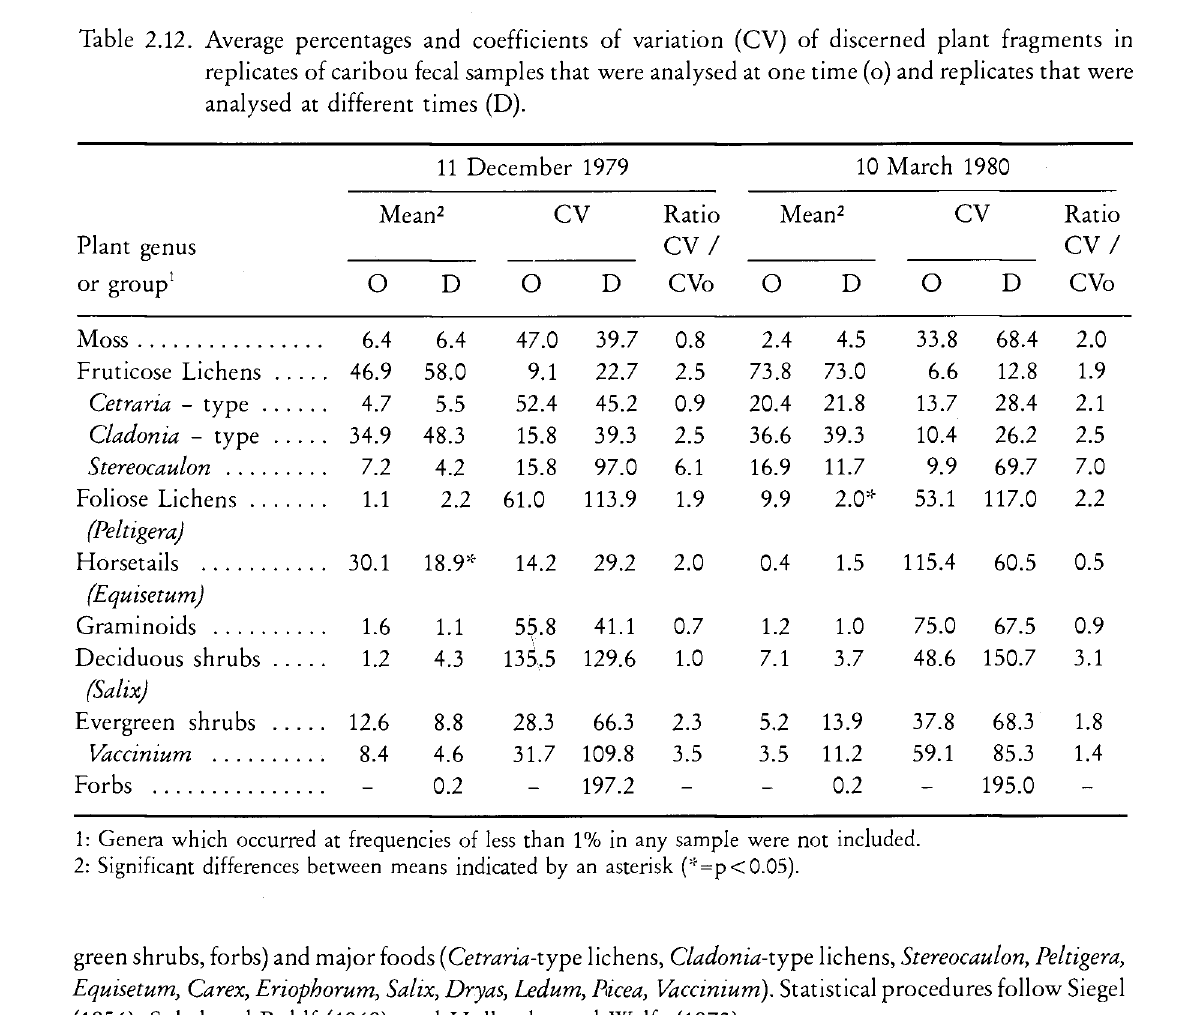
Table 2.12. Average percentages and coefficients of variation (CV) of discerned plant fragments in replicates of caribou fecal samples that were analysed at one time (o) and replicates that were analysed at different times